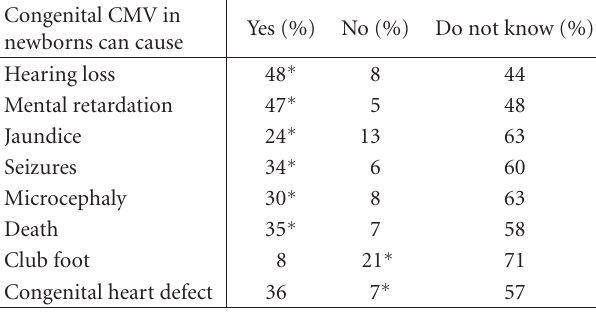
Table 3: Percentage of women responding to questions regarding which of the following clinical manifestations were caused by con- genital CMV in newborns. Note that these figures are among the 22% of the women who have heard of CMV.